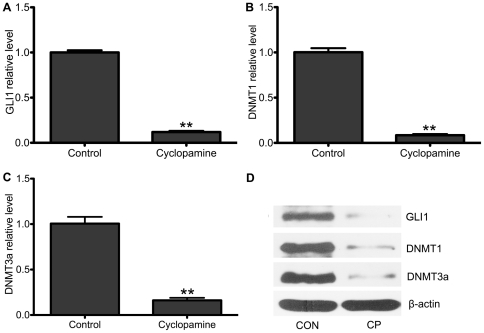
GLI1, DNMT1 and DNMT3a were inhibited in PANC-1 cell line after which treated by Cyclopamine.PANC-1 cells were treated with 10 µM cyclopamine for 24 hours, then relative expression of GLI1, DNMT1 and DNMT3a mRNA was assessed by qRT-PCR (A, B, C), while the expression of GLI1, DNMT1 and DNMT3a protein was analyzed by Western blot (D). The inset shows a substantial decrease in GLI1, DNMT1 and DNMT3a expression. The results were normalized to that of β-actin expression. All data were presented as the mean ± SD of three independent experiments.